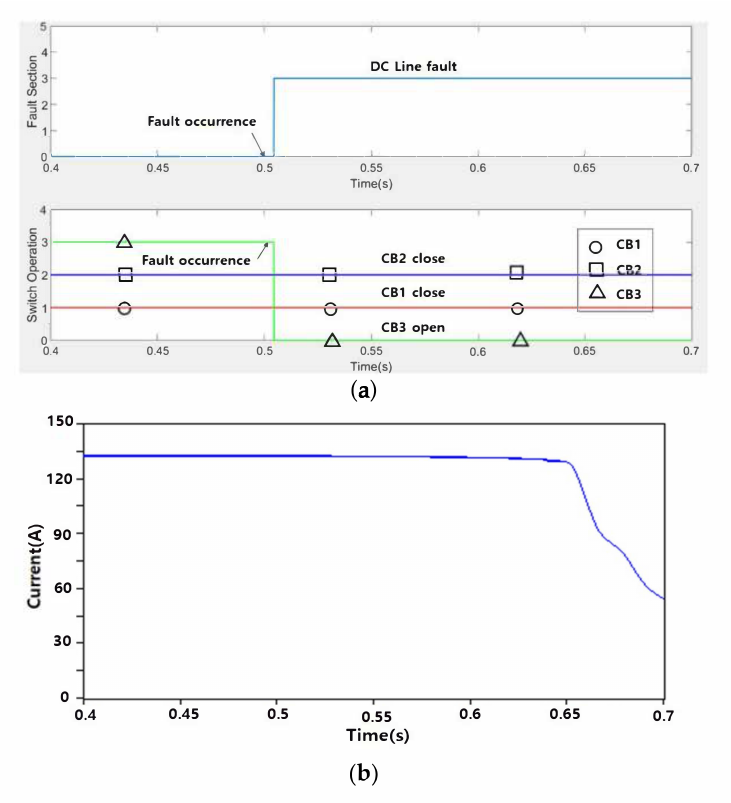
Figure 24. Simulation results of Case 10: ( a ) Fault section and CB operation and ( b ) Load current.